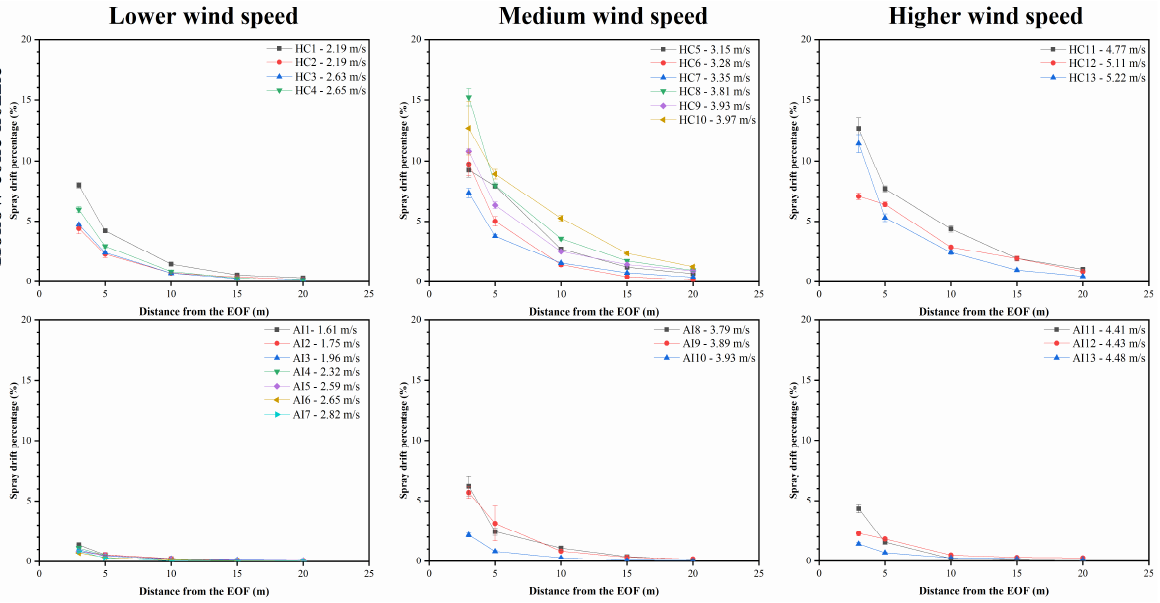
Figure 6. Spray drift profiles obtained from the ground petri dish using UASS with HC and AI nozzles at LWS, MWS, and HWS.